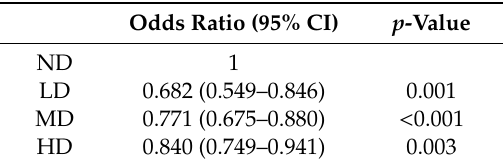
Table 2. Predictors of fatty liver.